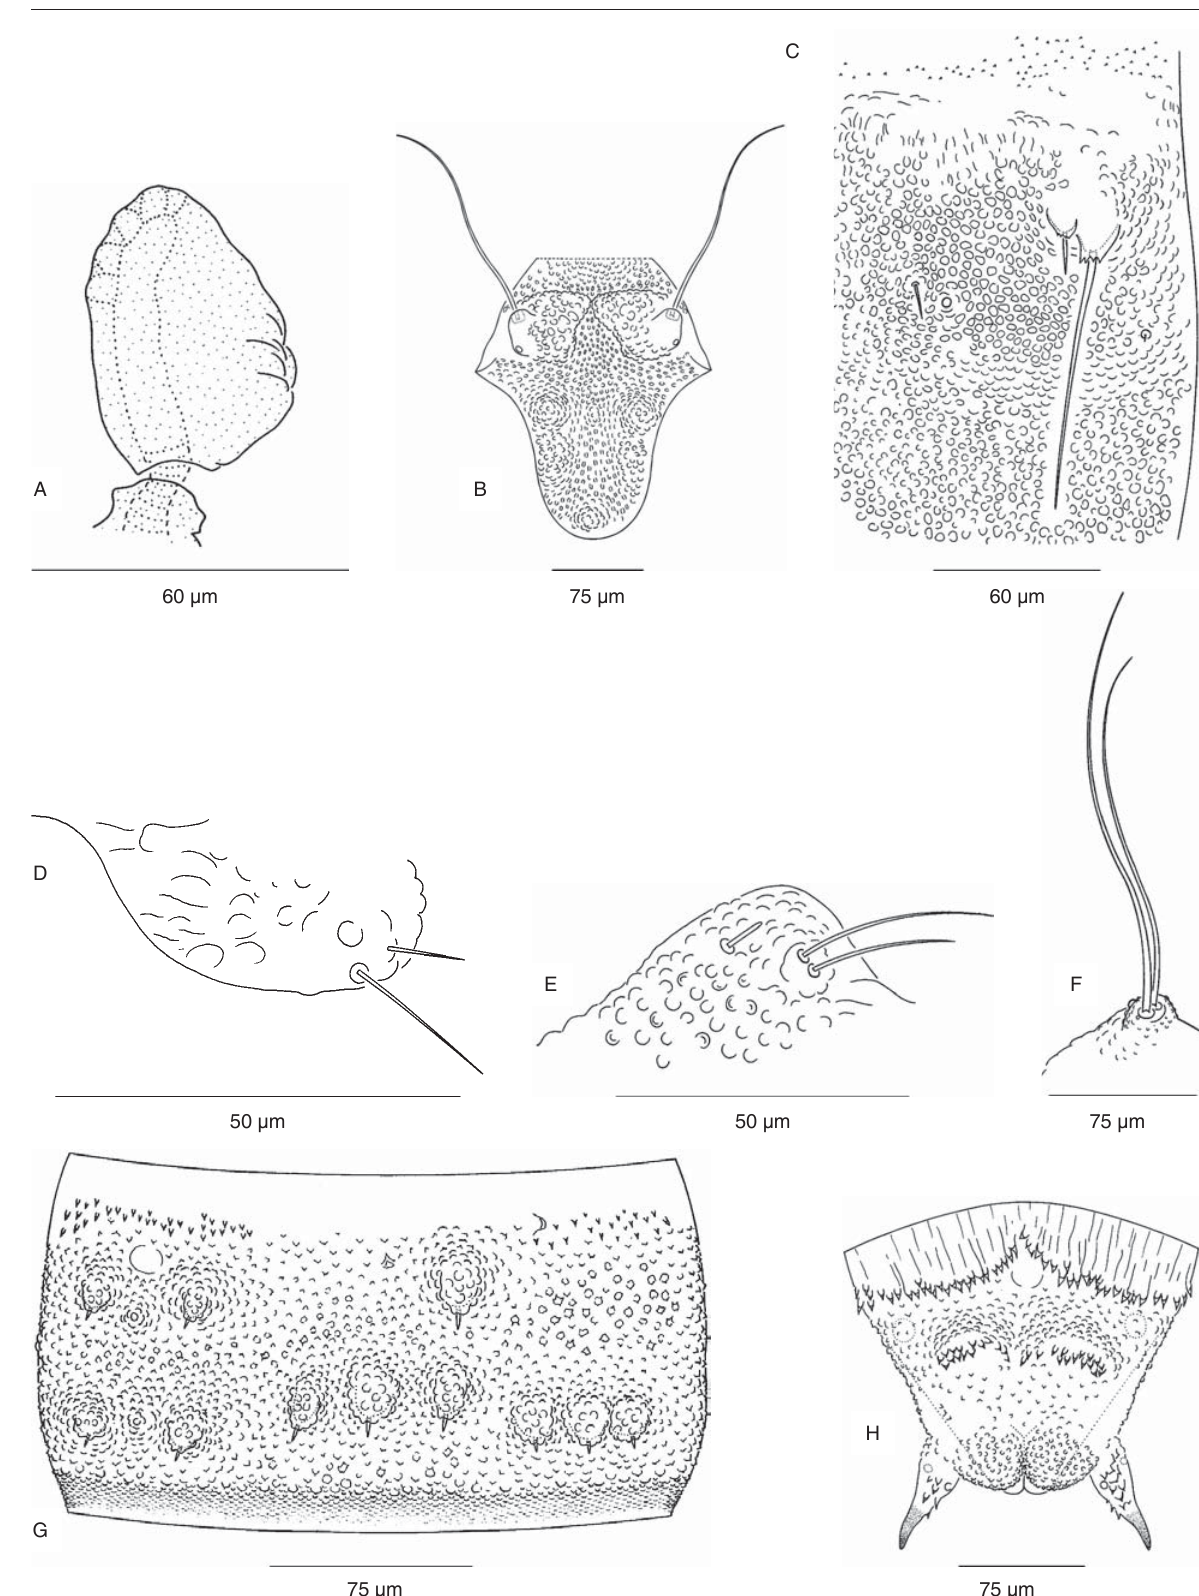
FIG. 4 The pupa of Culicoides loxodontis : (A) prothoracic respiratory organ; (B) ♂ operculum; (C) thorax; (D) ventrolateral setae (vl); (E) dorsolateral tubercle (dl); (F) anterodorsal tubercle (ad); (G) fourth abdominal segment; (H) caudal